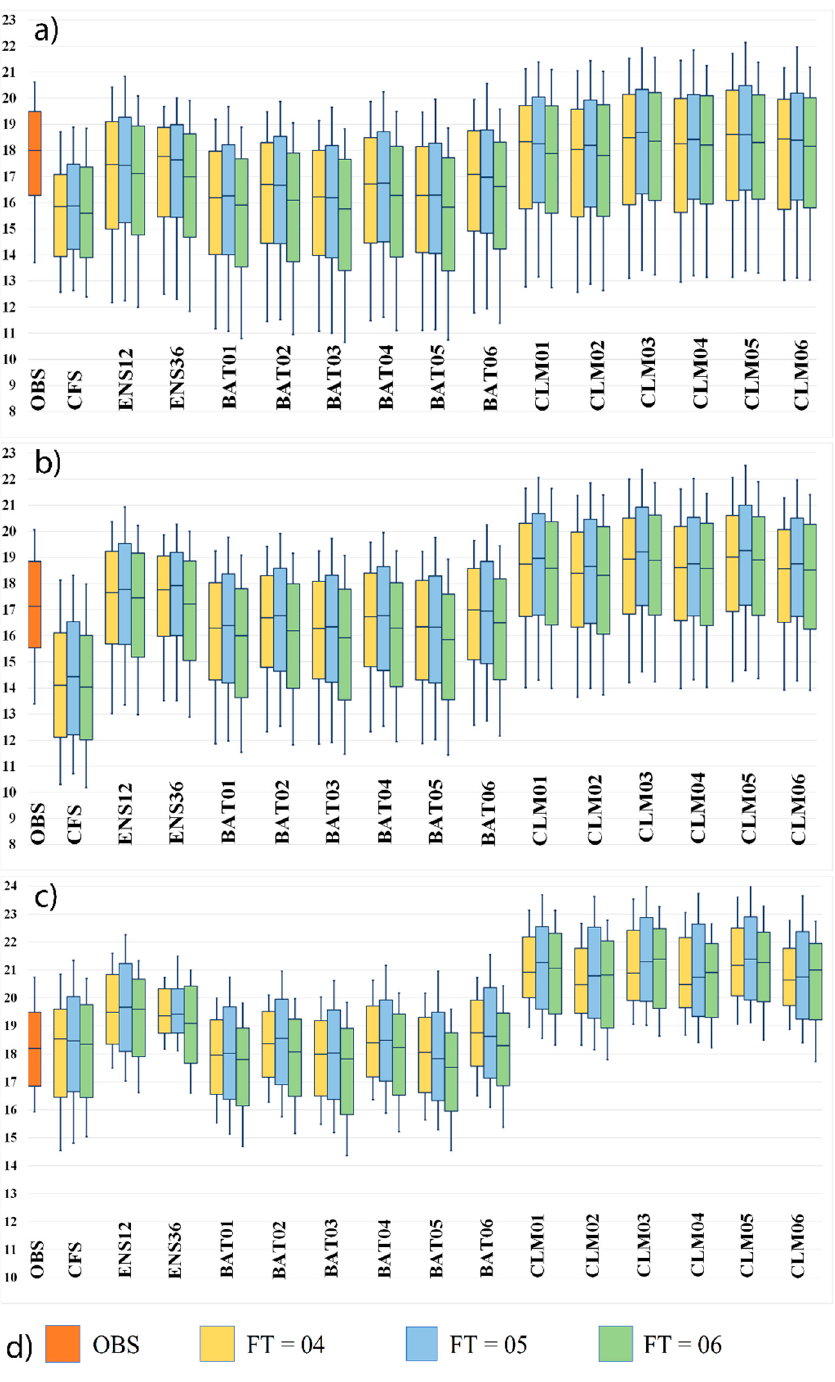
Figure 2. Average monthly temperature in 1998–2018 over R1 ( a ), R2 ( b ), and R3 ( c ) subclimate regions in February forecasted by the Climate Forecast System (CFS), biosphere − atmosphere-transfer scheme (BATS) configuration, Community Land Model version 4.5 (CLM) configuration, basic ensemble (ENS12), multirun ensemble (ENS36) for 4-, 5- and 6-month forecast time (FT) ranges and observation(OBS). (d) is the legend of plots. The box plots show the 25 th and 75 th percentiles; the hinges are the 10 th and 90 th percentiles. The unit is o C.